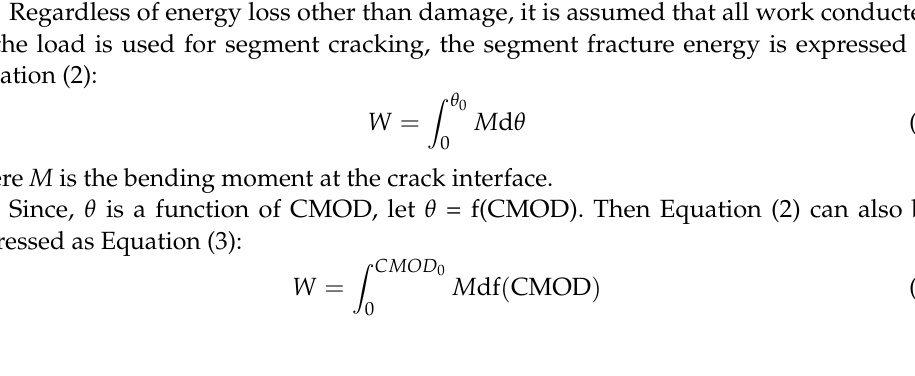
Figure 3. Schematic diagram of segment CMOD.